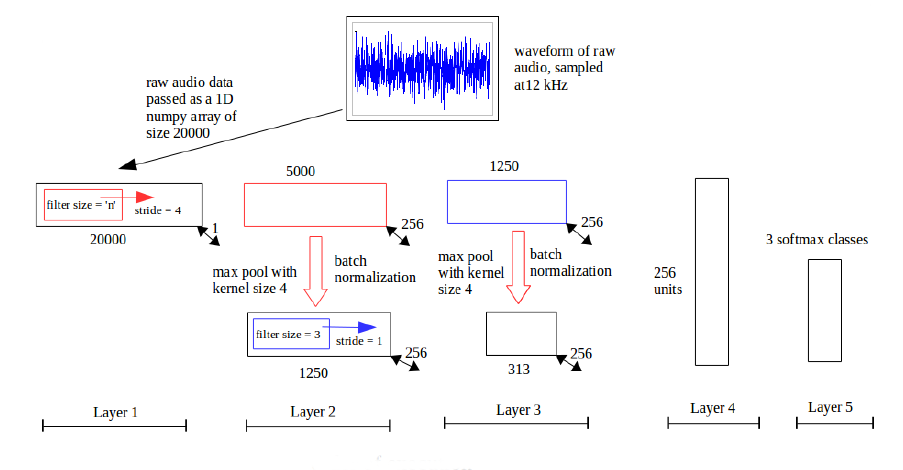
Figure 11. ConvNet 1. This ConvNet is similar to RawConvNet, but the custom layer (layer 4) of RawConvNet is replaced with an FC layer with 256 neurons.